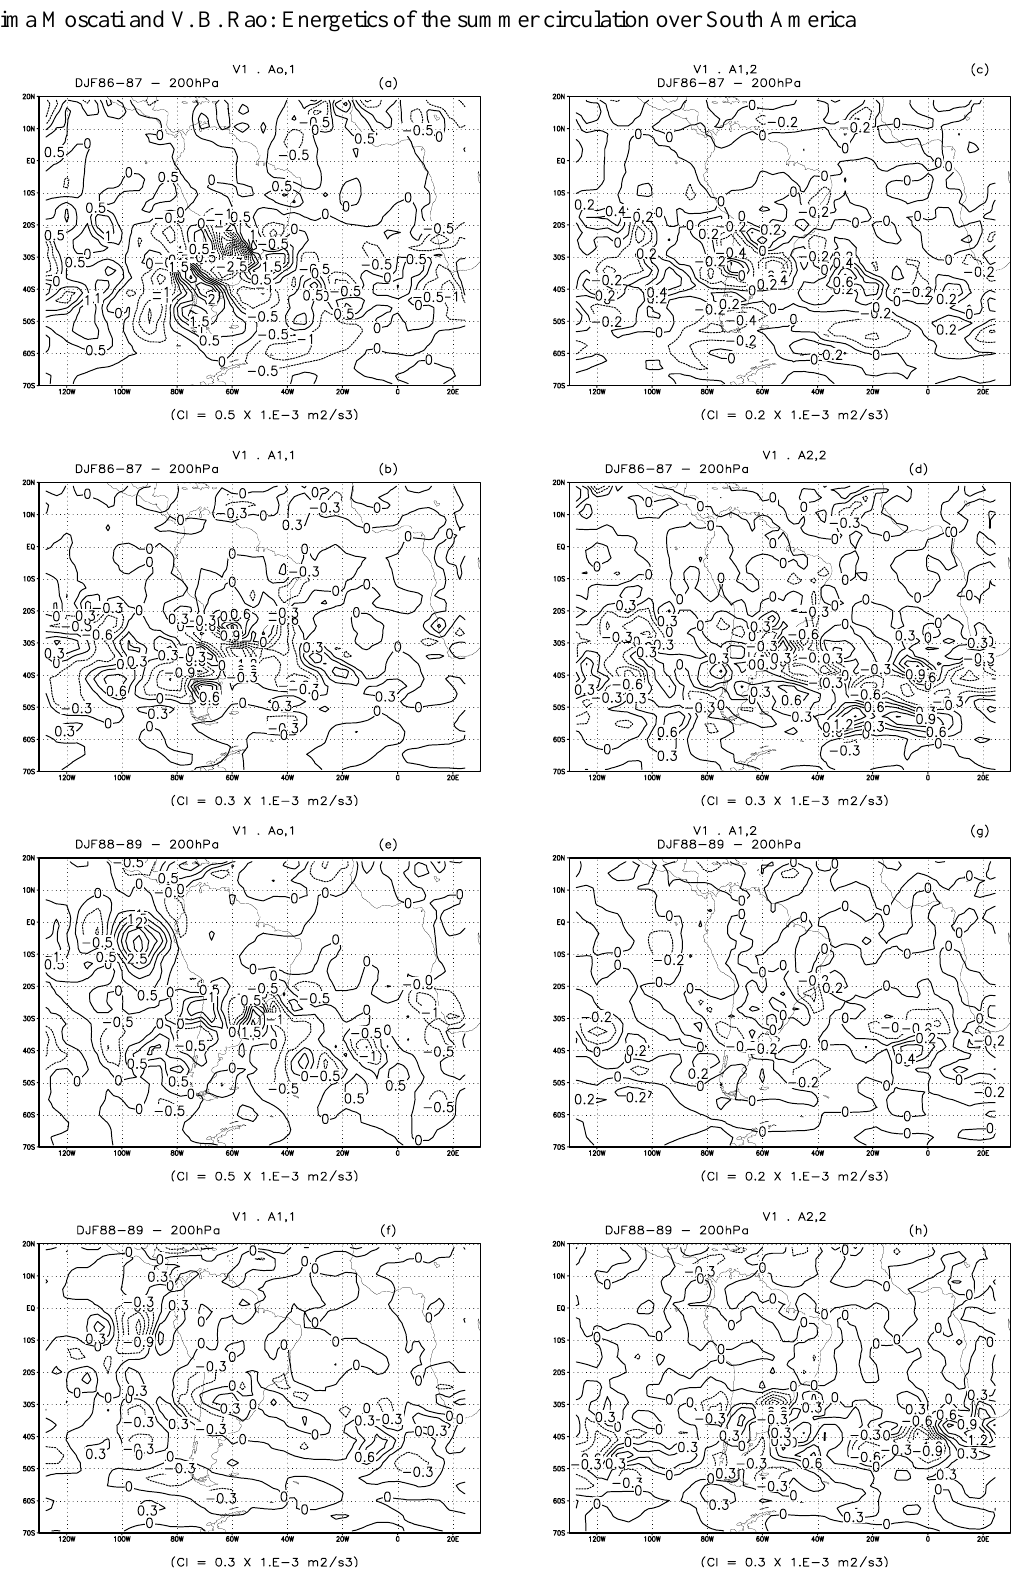
Fig. 6. Episodal average of the spatial distribution of the four individual advective terms in the summer of 1986–1987: (a) (cid:10) V 1 · A 0 , 1 (cid:11) , (b) (cid:10) V 1 · A 1 , 1 (cid:11) , (c) (cid:10) V 1 · A 1 , 2 (cid:11) , (d) (cid:10) V 1 · A 2 , 2 (cid:11) , and in the summer of 1988–1989: (e) (cid:10) V 1 · A 0 , 1 (cid:11) , (f) (cid:10) V 1 · A 1 , 1 (cid:11) , (g) (cid:10) V 1 · A 1 , 2 (cid:11) , (h) (cid:10) V (cid:11) . Values are multiplied by 10 − 3 m 2 s − 3 . CI stands for contour · A 1 2 , 2